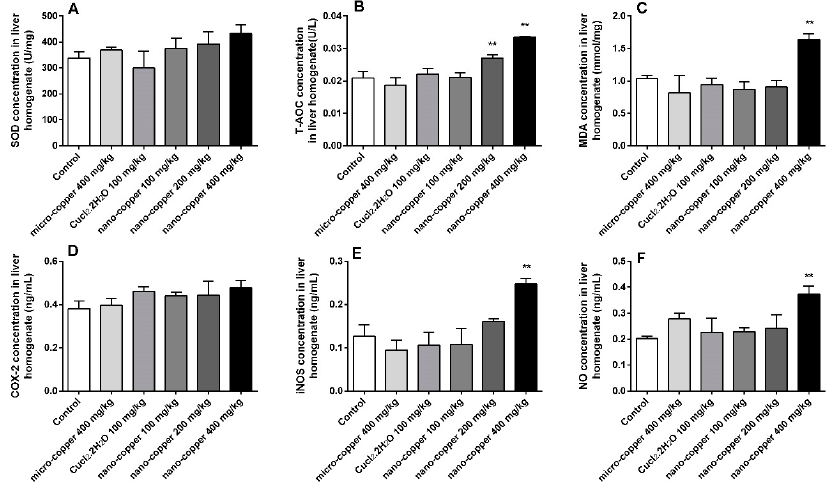
Figure 4. Oxidative index changes in rat livers. SOD ( A ), T-AOC ( B ), COX-2 ( C ), MDA ( D ), iNOS ( E ), NO ( F ). * p < 0.05, ** p < 0.01 vs. control group. Only 400 mg/kg of nano-copper induced the production of oxidative stress in hepatocytes of